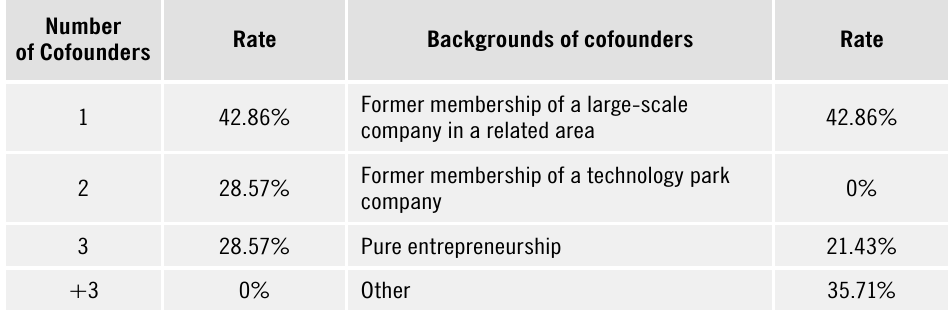
Table 2. Demographic features of cofounders of the respondent